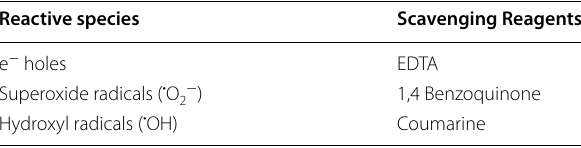
Table 7 Comparison of photocatalytic degradation efficiency of Co-doped TiO Nanomaterials